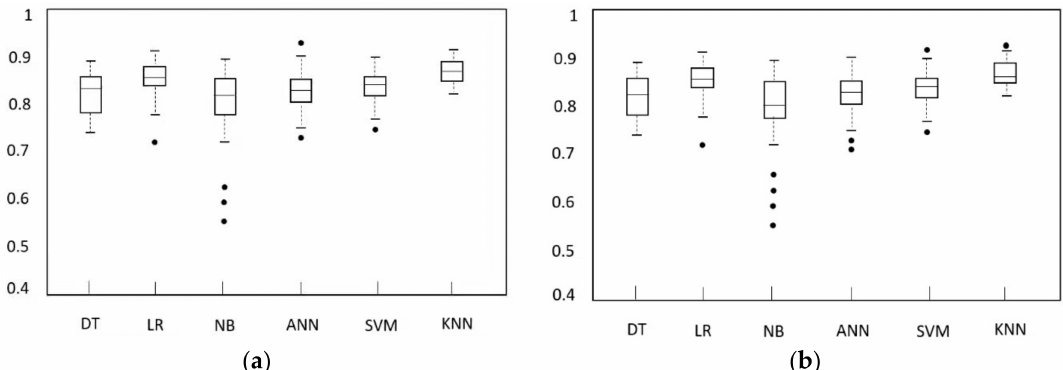
Figure 13. Comparison of the distribution of evaluation indicators of each classifier. ( a ) Comparison of classification accuracy of each classifier; ( b ) Comparison of AUC scores of each